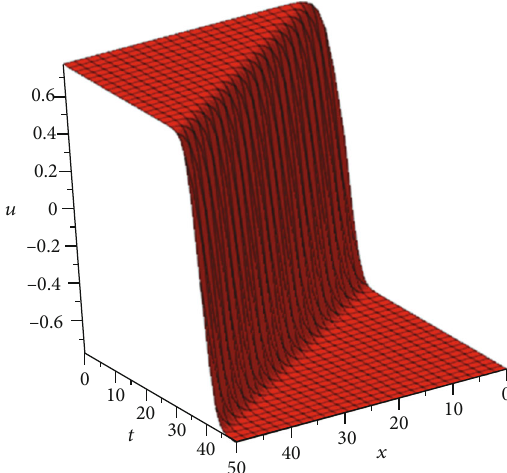
𝛽 = 1; solution (27) red: 𝛼 = 1, blue: 𝛼 = 0.7, yellow: 𝛼 = 0.4 Figure 4: 3D plot of solution (27) for various values of α , and k = 1, ρ = 2, c = − 1 : 2, C 4 = C 5 = 1